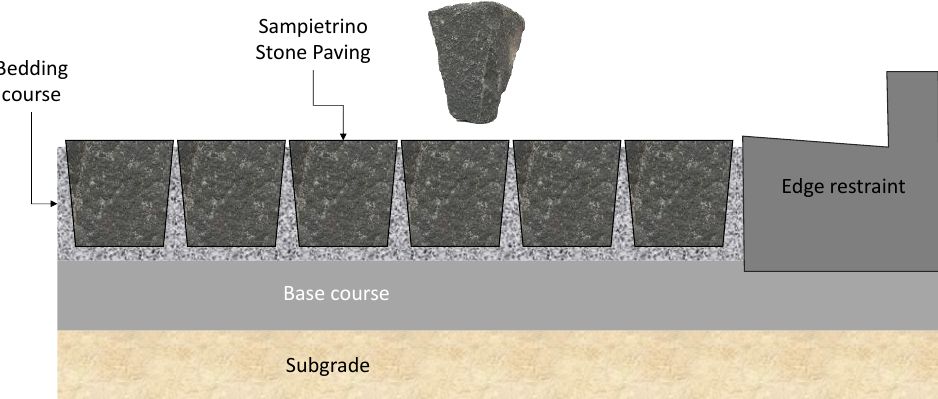
Figure 2. Cross section of a sampietrini pavement.